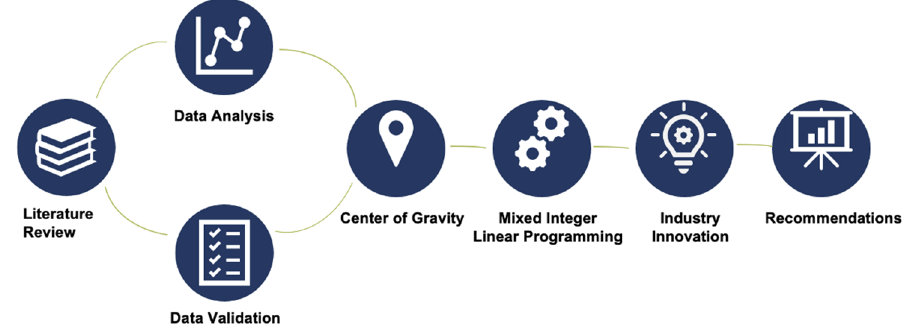
Figure 2. Methodology Flow Chart.